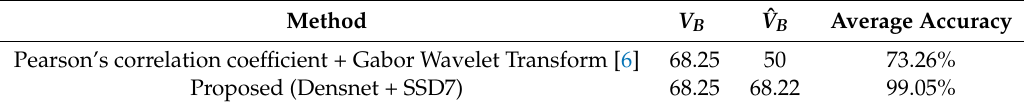
Figure 14. Final results of the wind turbine velocity estimation. ( a ) Comparison of different models with different accuracies. ( b ) Accurate estimation of the velocity based on DenseNet with accuracy = 99%. Table 5. Comparison of the average accuracy of the velocity estimation algorithm found on DB3